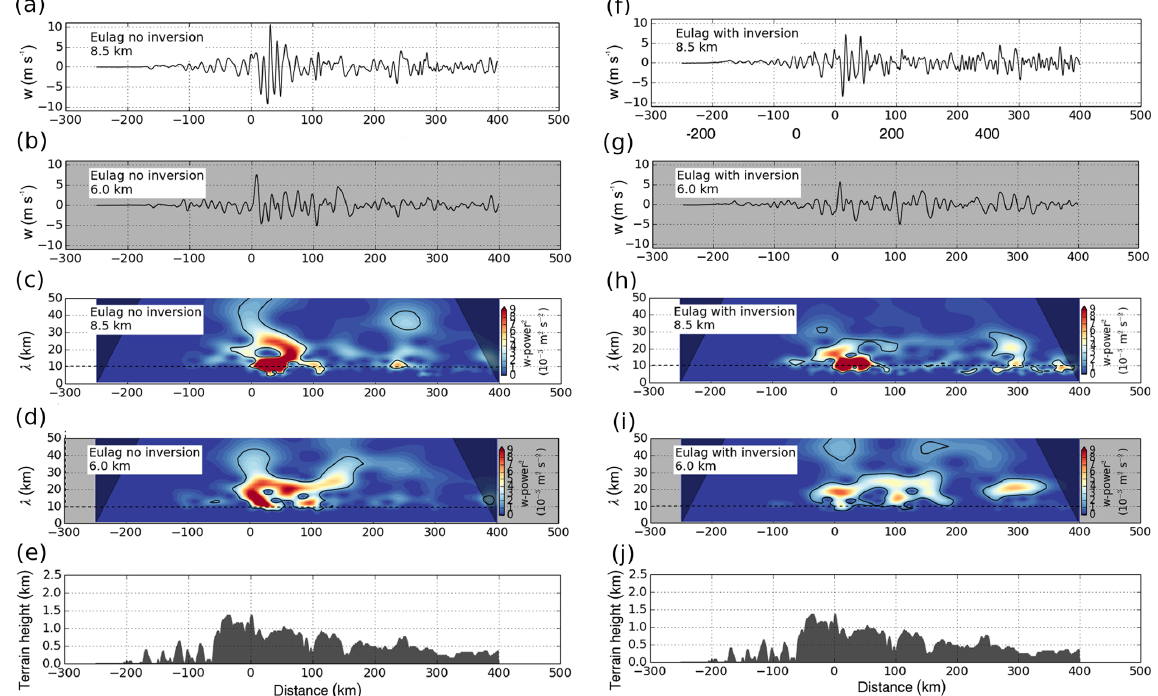
Figure 15. Vertical velocity and corresponding wavelet spectra of the simulations shown in Fig. 14 ( a–e without TIL, run 5, f–j with TIL, run 6). Panels (a, c, f, h) are at the altitude of the tropopause and (b, d, g, i) are below the tropopause. Panels (e) and (j) show the terrain in the domain.